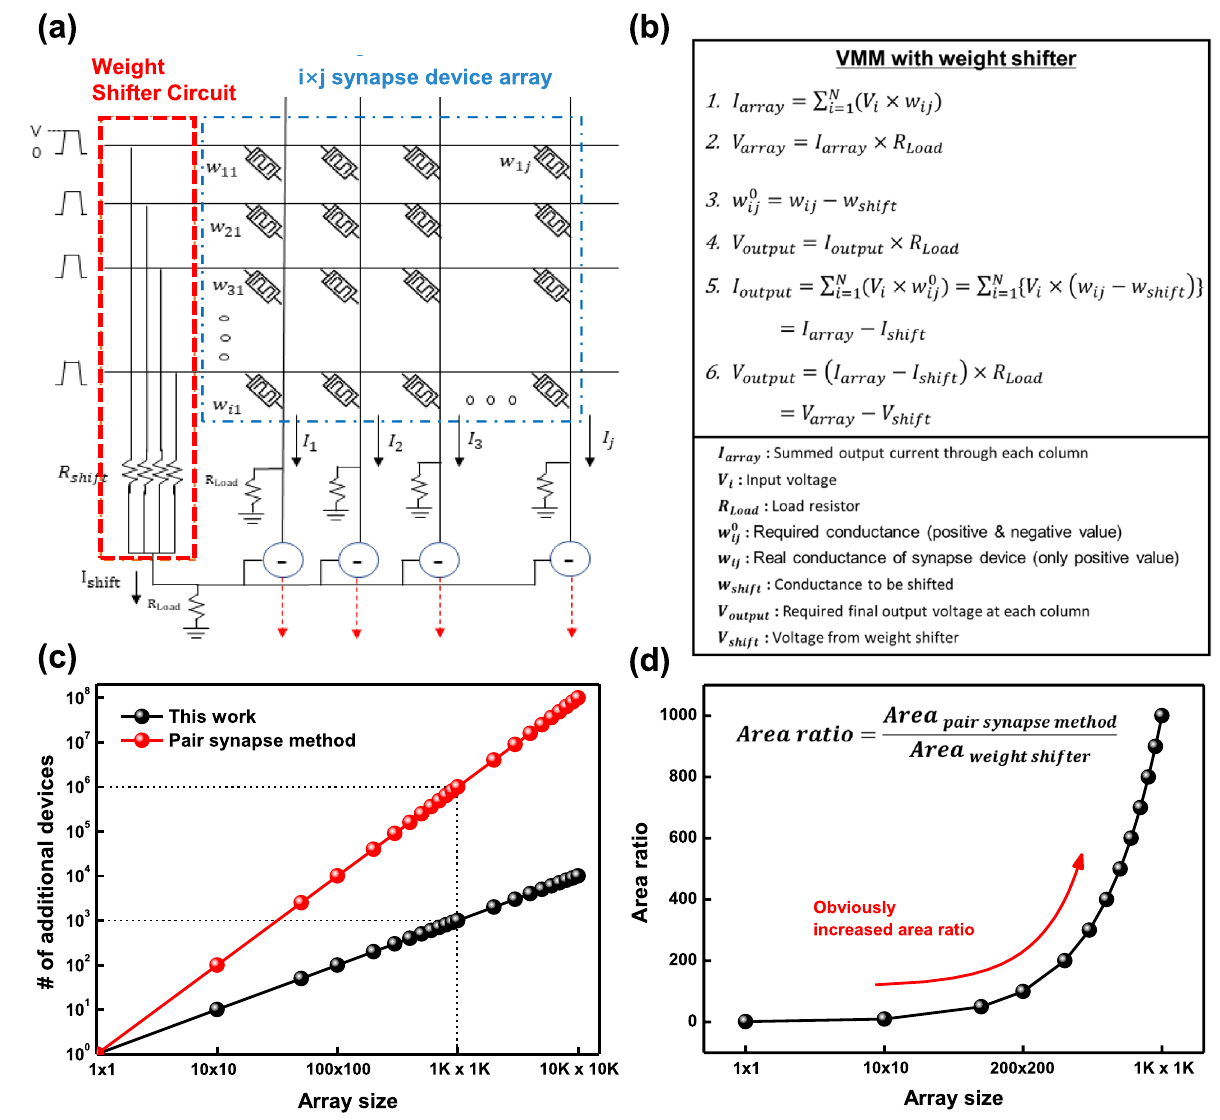
Figure 2. ( a ) Schematic of the weight shifter with i × j synapse-device array. ( b ) Theoretical equation of the weight shifter. The conductance value of synapse device (w ij ) can be considered as positively shifted weight 0 + w shift ). When we consider that output results of the VMM will be total columnar current (I array ), it value ( = w ij is derived from multiplication between input data (V i ) and conductance of synapse device (w ij ). Then, output voltage of one column (V array ) can result from multiplying the I array by load resistor (R Load ). In the same manner, output voltage of the weight shifter can be derived by multiplying output current of the weight shifter (I shift ) by R Load . As a result, the final output voltage of the VMM (V output ) can be obtained by subtracting the V shift from V array . ( c ) Comparison of additionally required devices between conventional pair synapse method and proposed weight shifter for realization of the negative weight. ( d ) Area ratio (= area of conventional method/area of weight shifter) depending on array